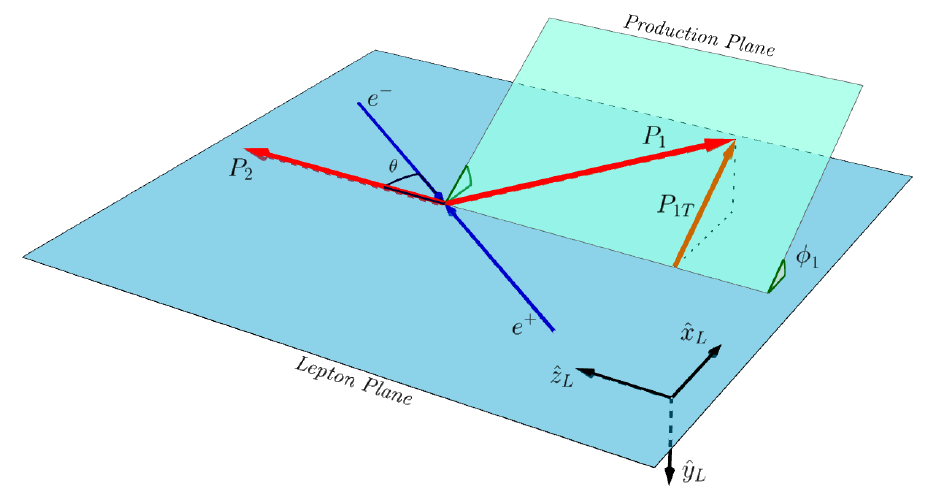
Figure 1 . Kinematics for the process e + e − → h 1 h 2 + X in the hadron-frame